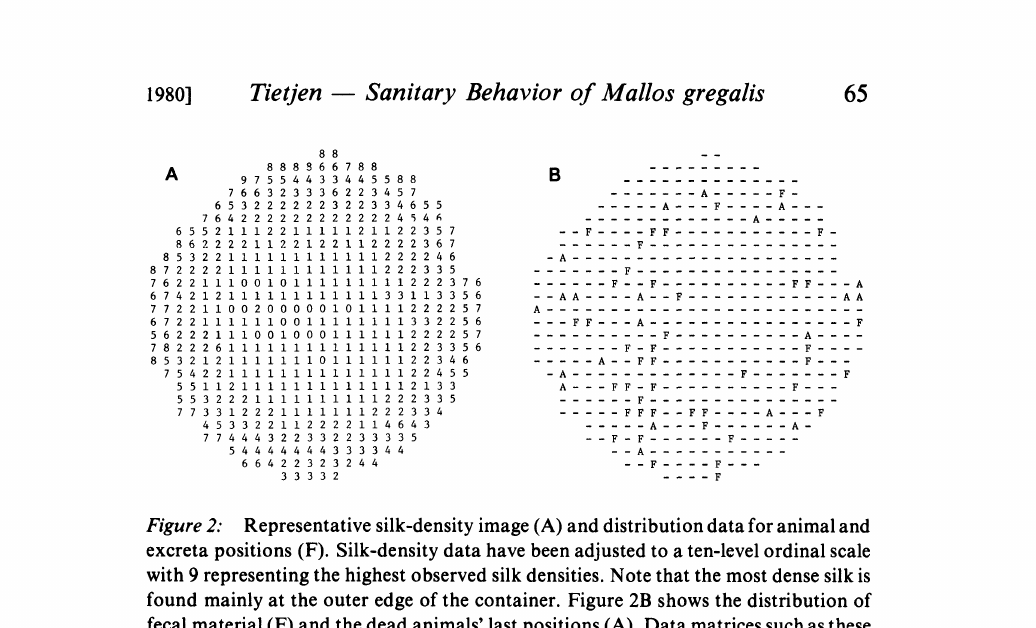
66 0011221000 A 44110000121113 842011233222011014